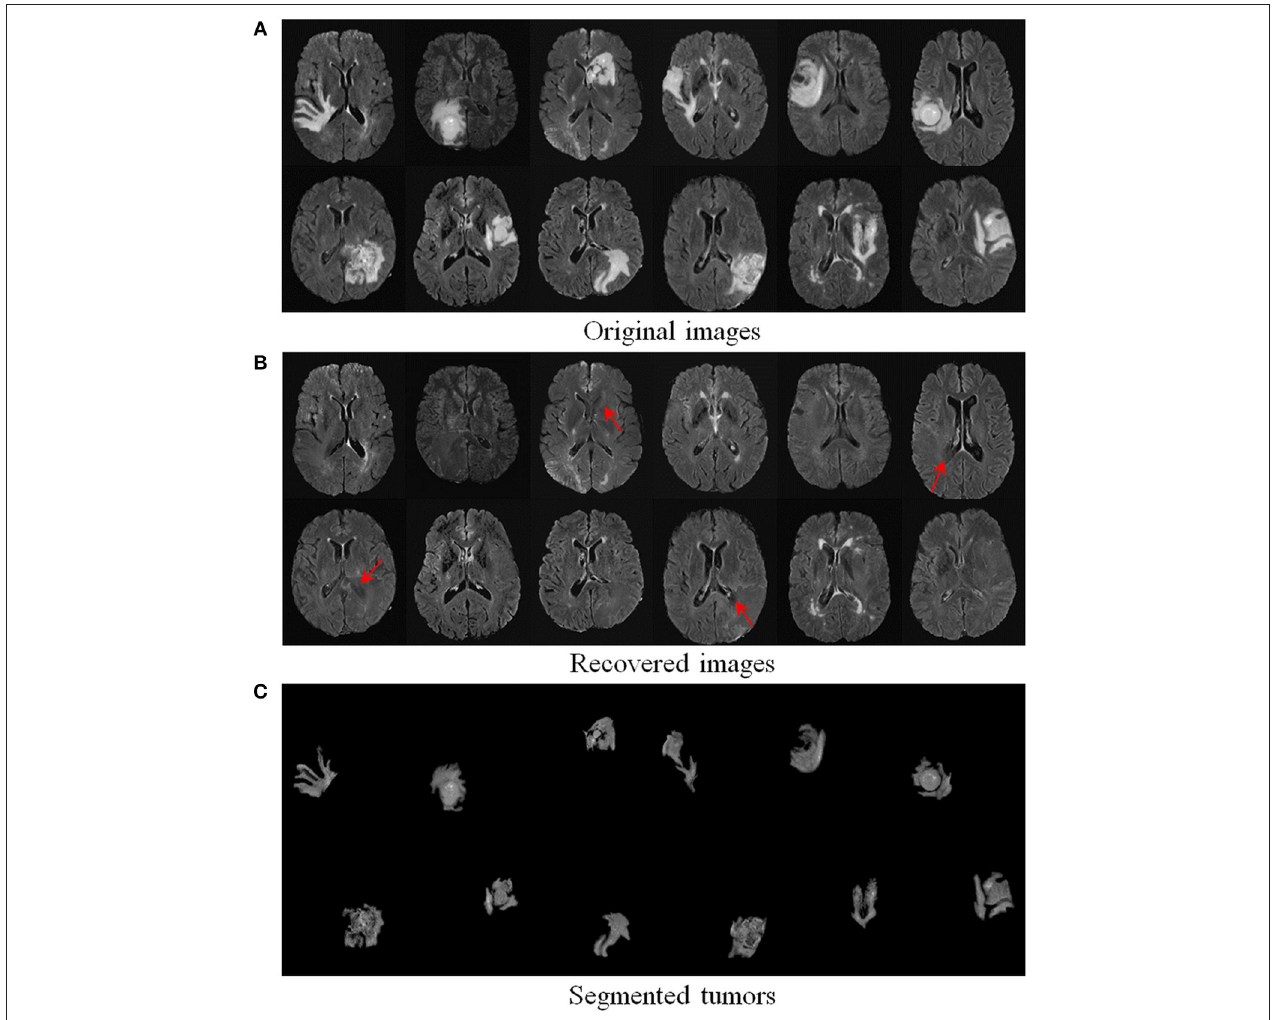
FIGURE 6 | Recovery and segmentation of (A) real MR brain tumor images from BRATS2018 (Menze et al., 2015); (B) the recovered images with normal brain appearances, (C) the tumor segmentation results. Red arrows indicate well recovered brain